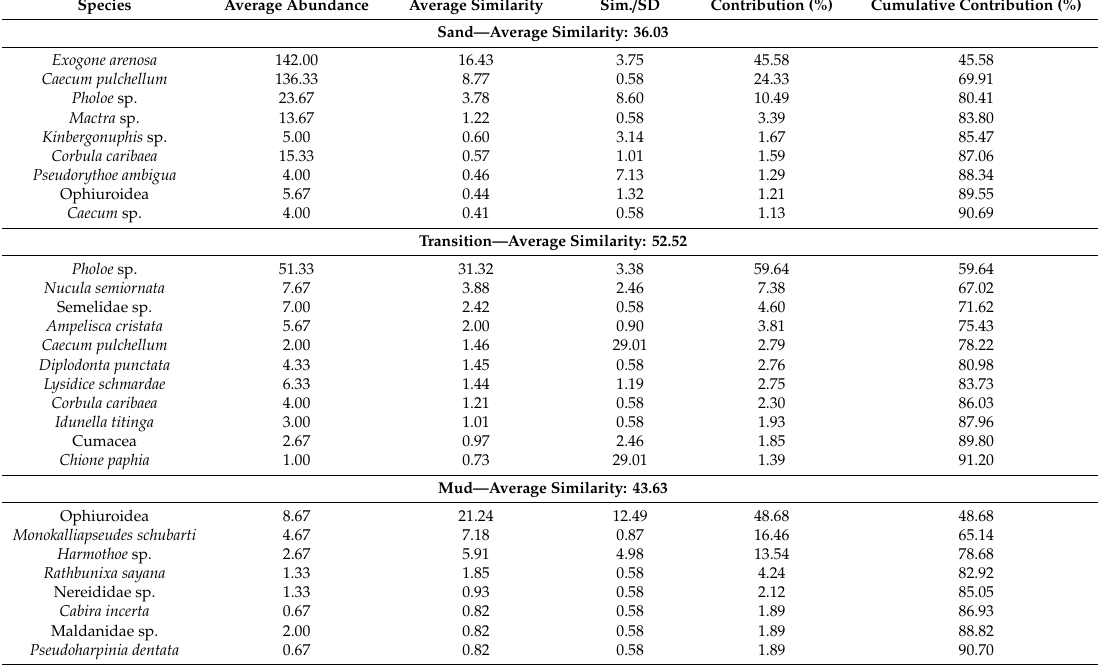
Table 1. Similarity percentages (SIMPER) of the most representative macrofaunal species (up to 90% cumulative contribution) collected in the three zones of the study area in summer. Average abundance is given in individuals m − 2 . Sim. / SD is the ratio of average similarity divided by its standard deviation